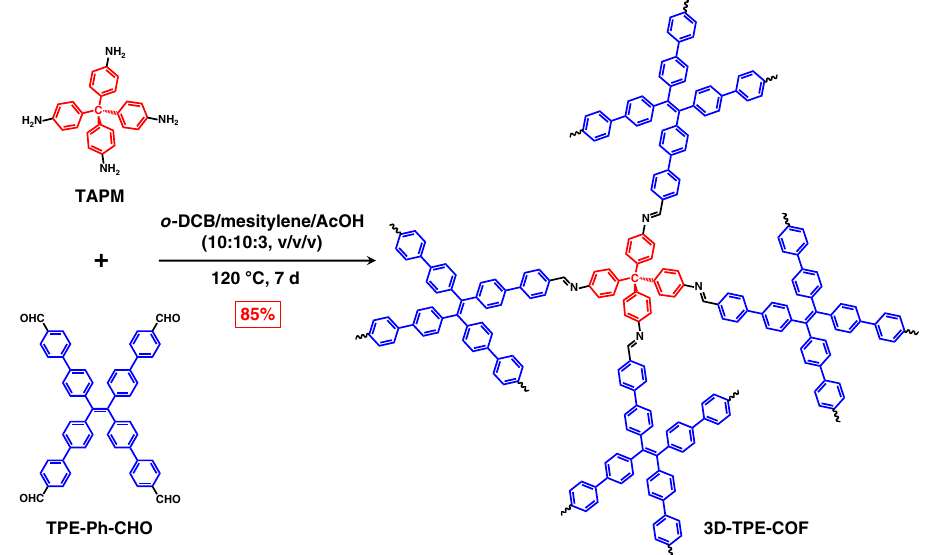
Fig. 1 Chemical Structure. Schematic representation of the synthesis of 3D-TPE-COF